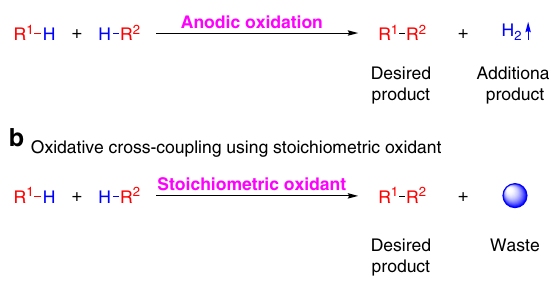
Fig. 2 Oxidative cross-coupling reactions of R 1 -H with R 2 -H. a Electrochemical oxidative cross-coupling with H 2 evolution. b Oxidative cross-coupling using stoichiometric